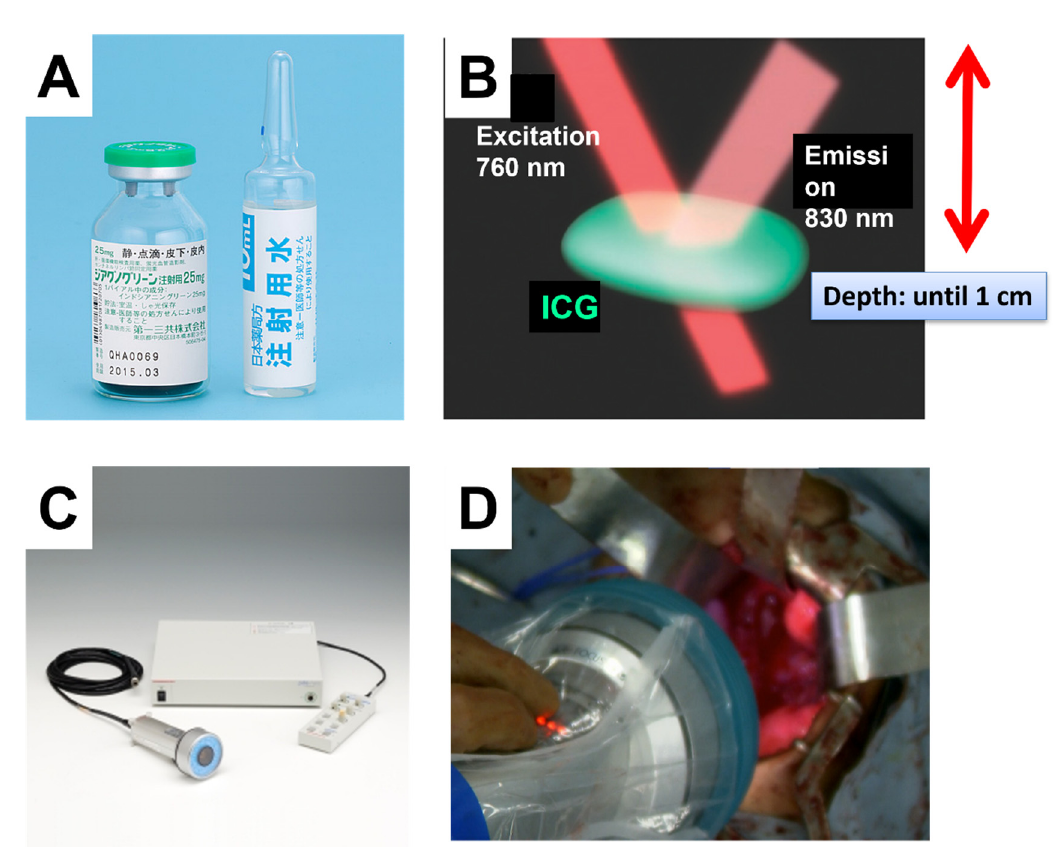
Figure 1. PDE system customized for the detection of ICG fluorescence (Hamamatsu Photonics: PDE System ® ). ( A ) Indocyanine green (ICG) vial. ( B ) Schema of ICG detection. The excitation light is 760 nm, and the emission signal is 830 nm. ( C ) PDF detector (handle type). ( D ) Intraoperative detection of ICG signals.